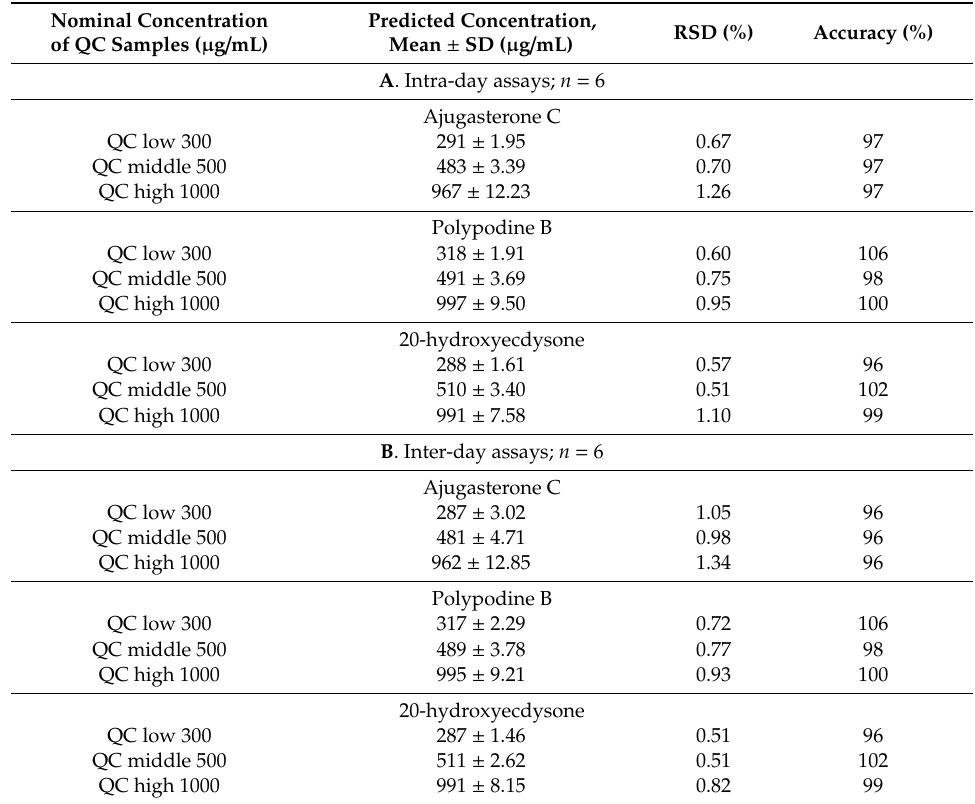
Table 2. Intra-day and inter-day precision and accuracy of compounds 1 – 3 (quality control, QC; relative standard deviation,